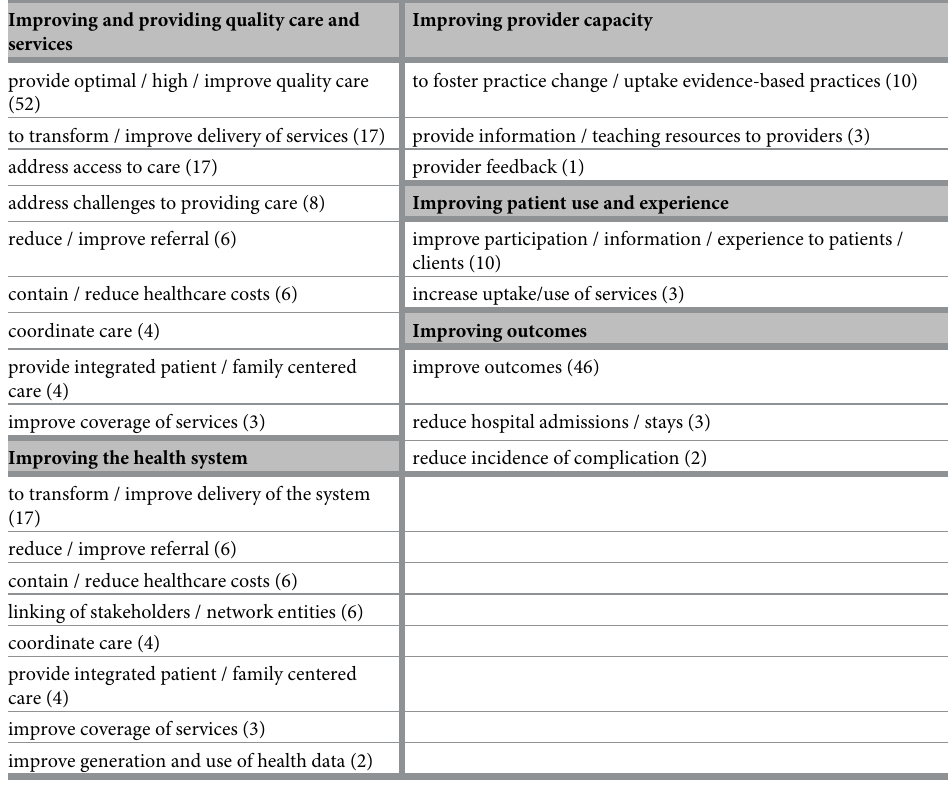
Table 5. Reported network purposes by category with corresponding number of references from the selected literature.